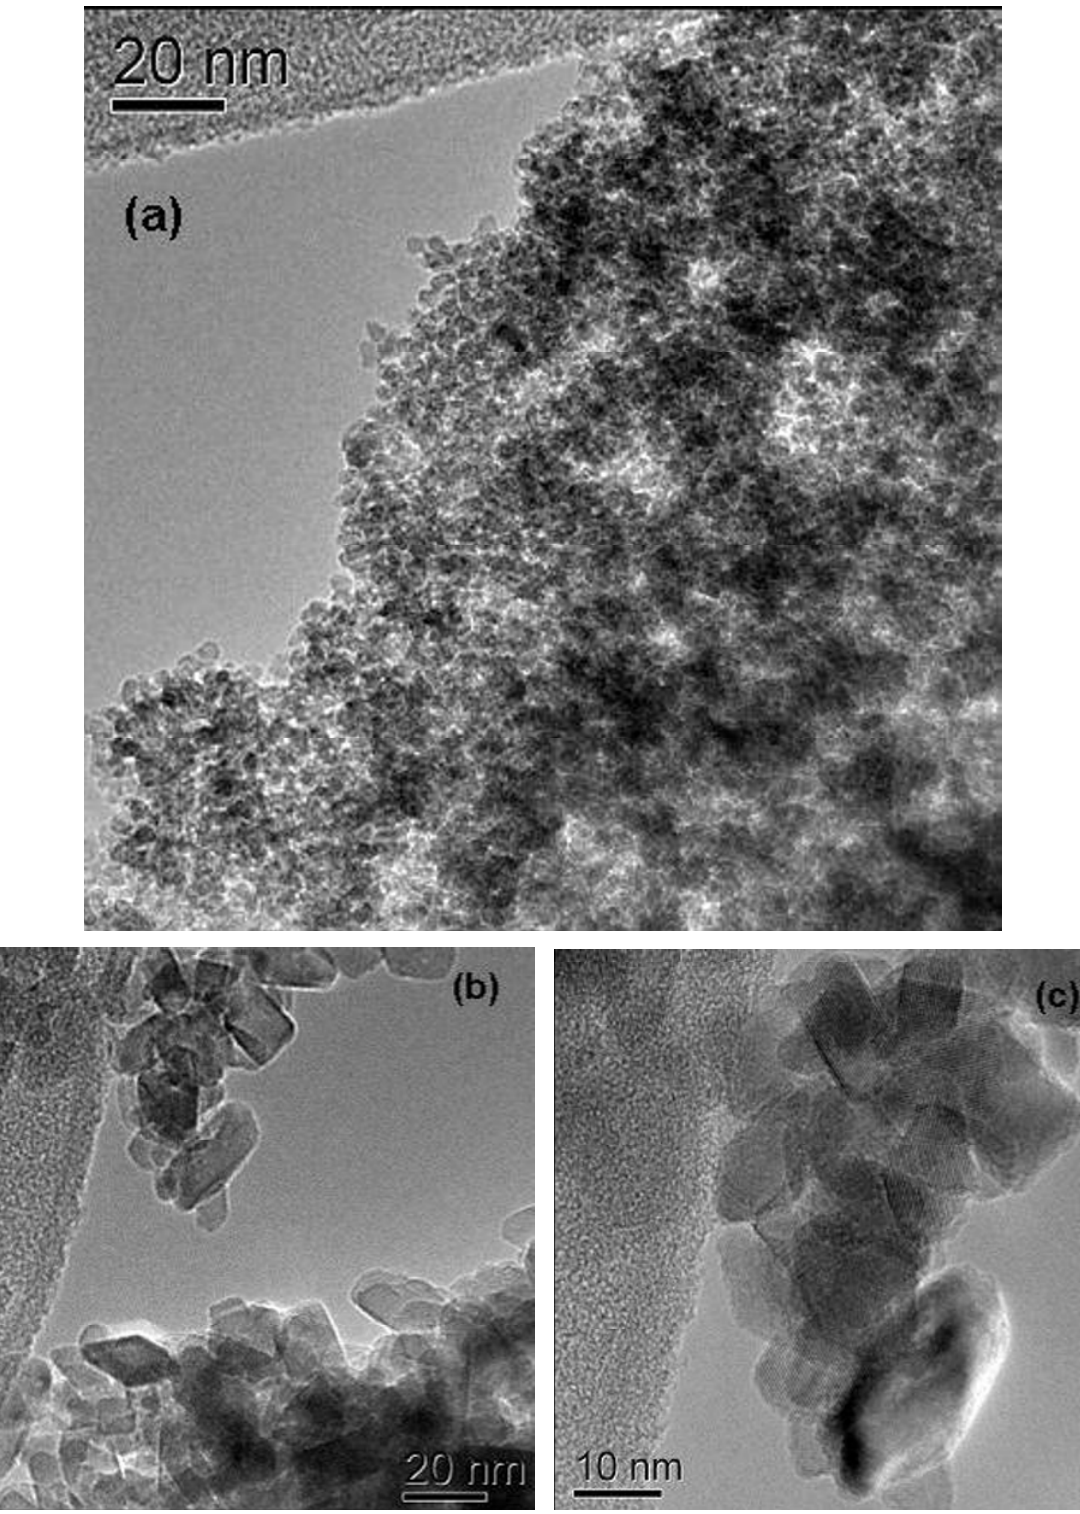
Figure 5. TEM images of anatase crystallites in a) sample A6 and b,c) sample